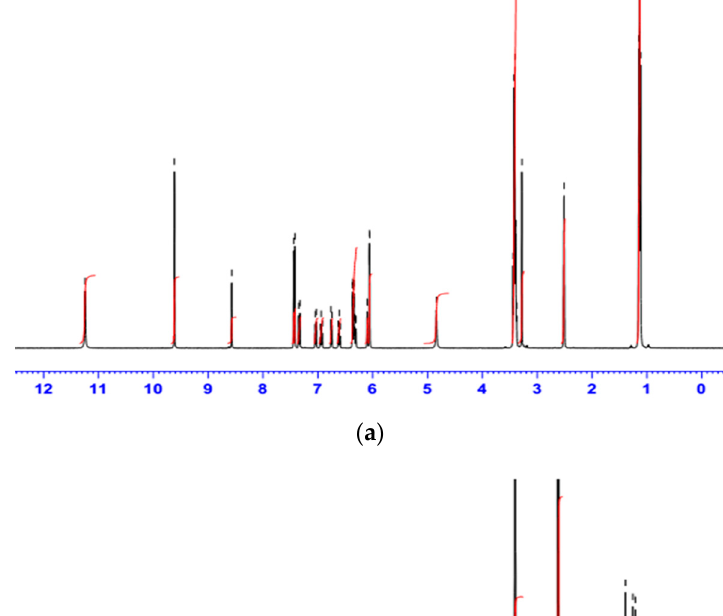
2 L imine ligand ( a ) and its PdL complex ( b